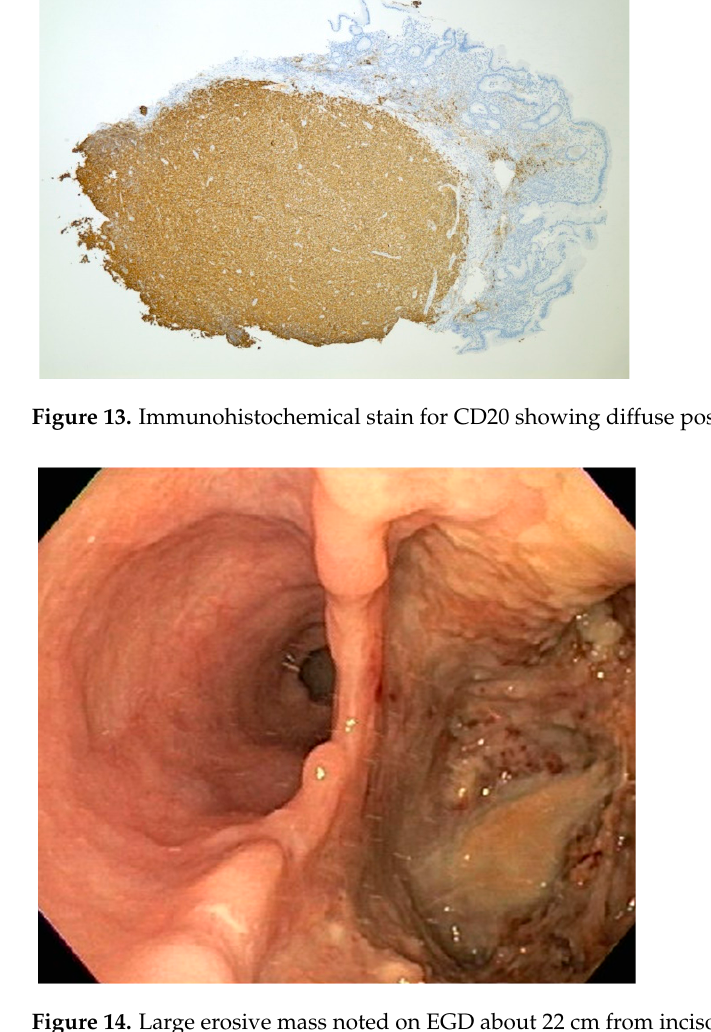
Figure 15. Innumerable polypoid appearing gastric lesions throughout the stomach.